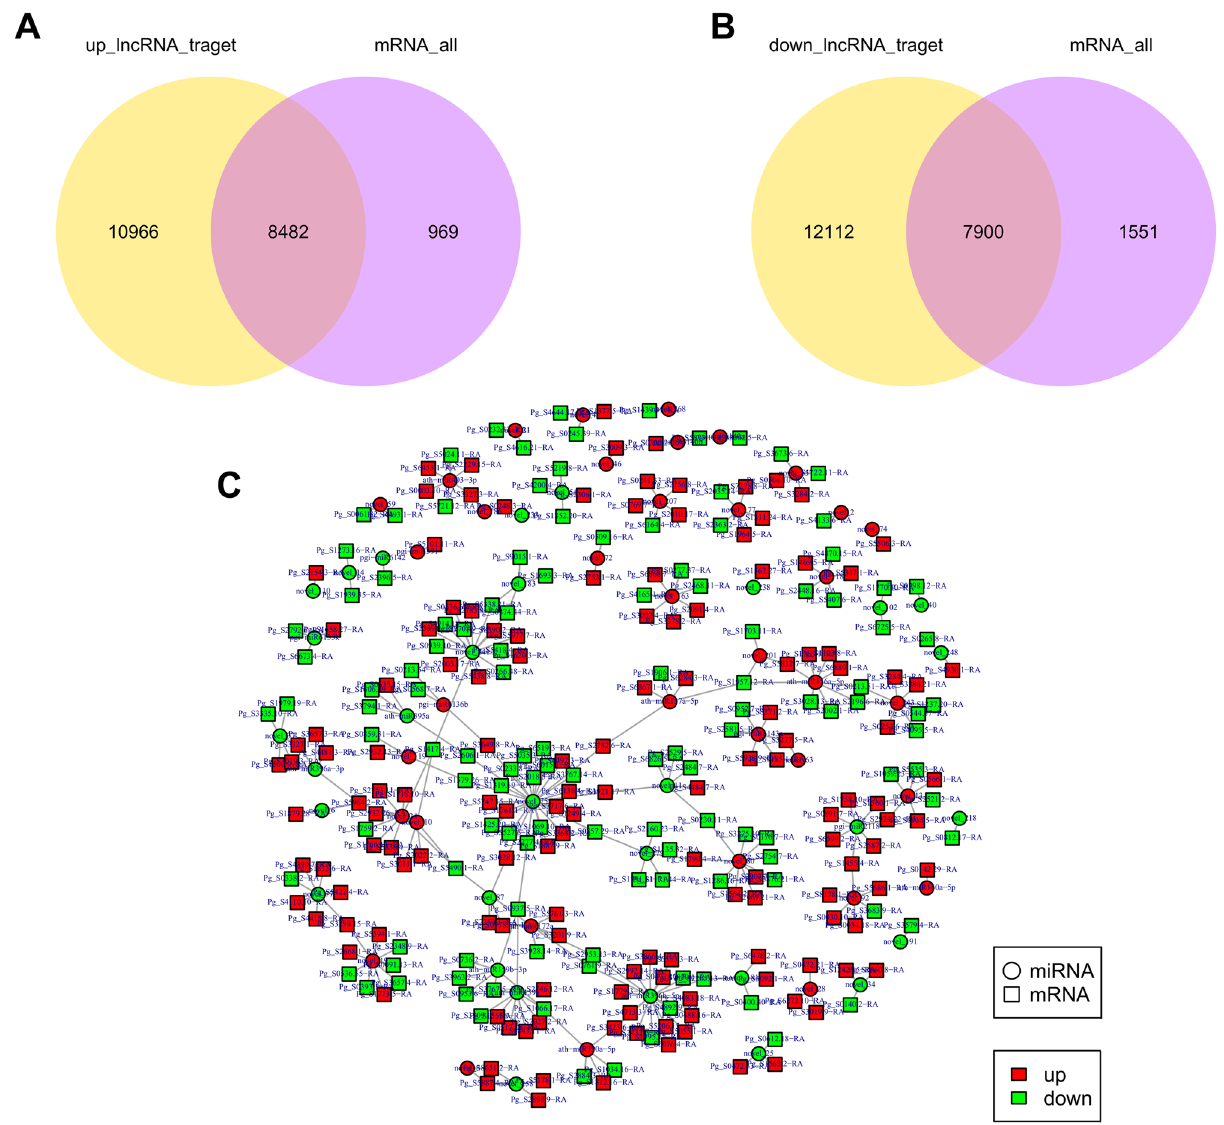
Figure 11. Association analysis of mRNA and ncRNA in the diseased tissues. ( A ) Venn diagram showing the overlap number of targeted mRNA of up regulated lncRNAs and differentially expressed mRNAs; ( B ) Venn diagram showing the overlap number of targeted mRNA of down regulated lncRNAs and differentially expressed mRNAs; ( C ) Interaction network of miRNA-mRNA in ginseng tissues. Image generated with R 3.6.3 (https:// www.R- proje ct. org) 51 ggplot2 package (https:// ggplo t2. tidyv erse. org) and network diagram made by Cytoscape sofware 3.8.2 (https:// cytos cape. org/) 57